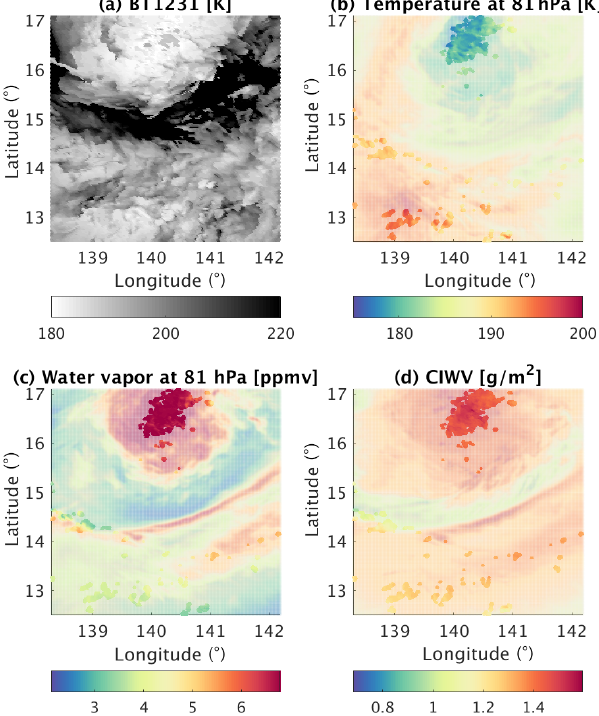
Figure 1. GEM-simulated atmospheric conditions used as the truth in the simulation experiment. (a) Brightness temperature (K) at 1231cm − 1 . (b) Temperature (K) at 81hPa. (c) Water vapor vol- ume mixing ratio (ppmv) at 81hPa. (d) Column integrated water vapor (CIWV) from 110 to 70hPa. Solid color-coded dots mark the overshooting deep convective clouds sampled via the BT-based criterion. The test set used to conduct the retrievals was randomly selected from these samples. Partially transparent colors show the rest of the simulated fields. The variable fields were taken 410min after the initial time